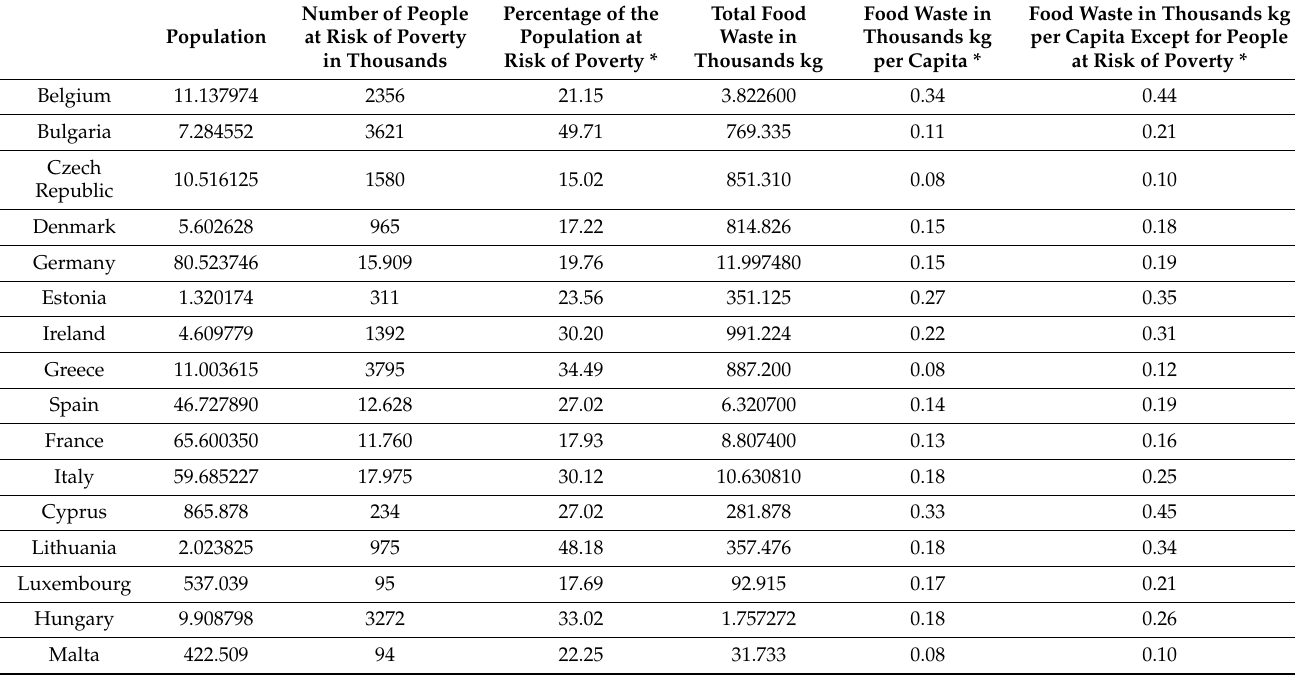
Table 2. Poverty and food waste in the individual countries of the EU in 2012. Source: created by authors according to data from [61–65].